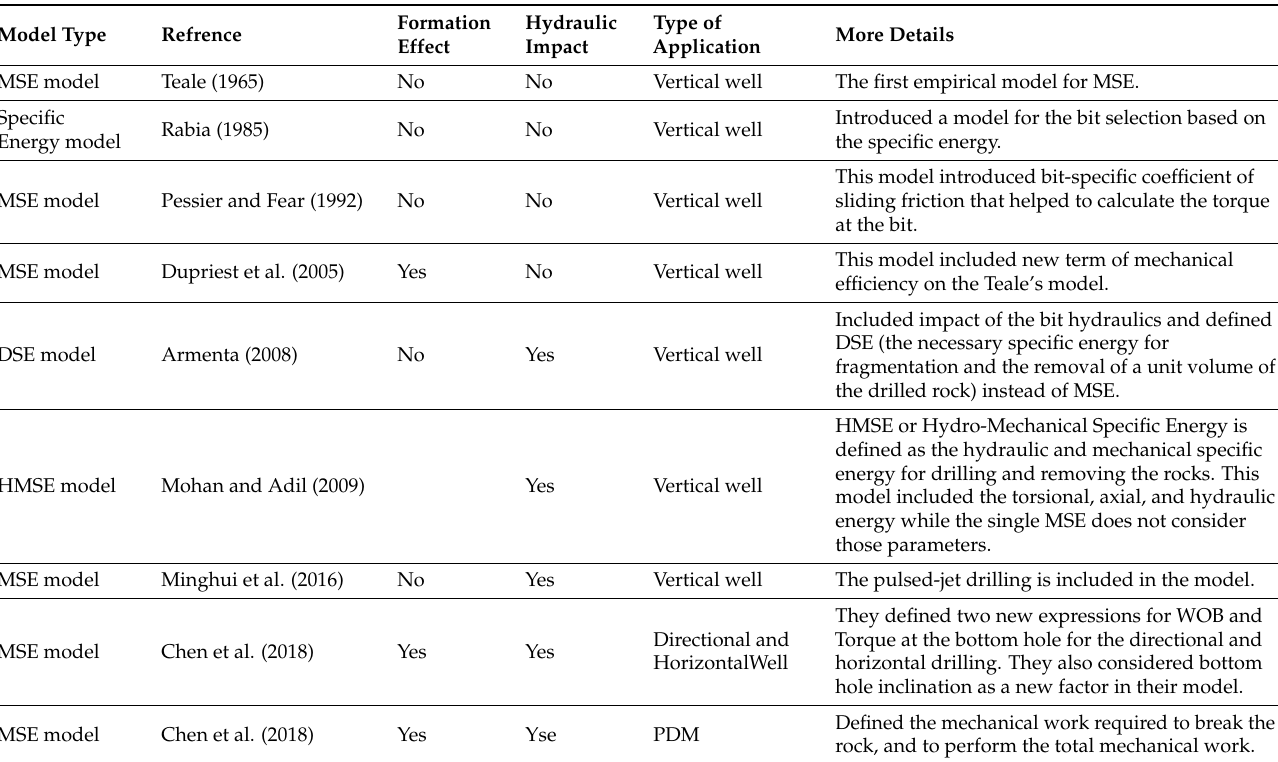
Table 1. Description of empirical MSE